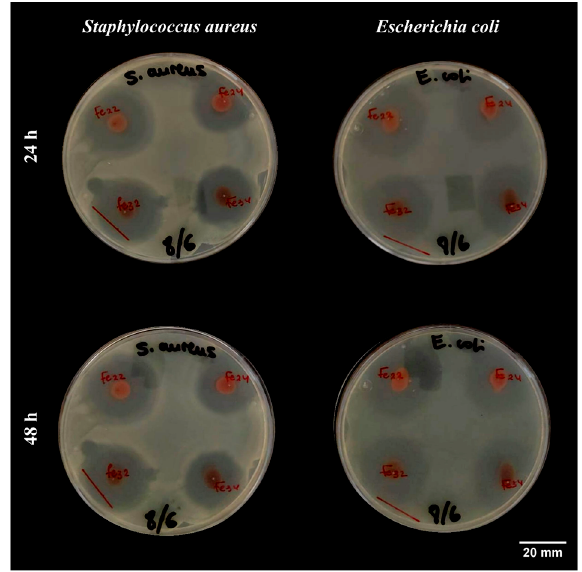
Figure 6. The inhibition zones (diameters) produced by selected GS-NPs Fe 22 . GS-NPs calcinated at 200 °C for 2 h, Fe 24 . GS-NPs calcinated at 200 °C for 4 h, Fe 32 . GS-NPs calcinated at 300 °C for 2 h and Fe 34 . GS-NPs calcinated at 300 °C for 4 h against Staphylococcus aureus ( S. aureus ) and Escherichia coli ( E. coli ) over 48 h.